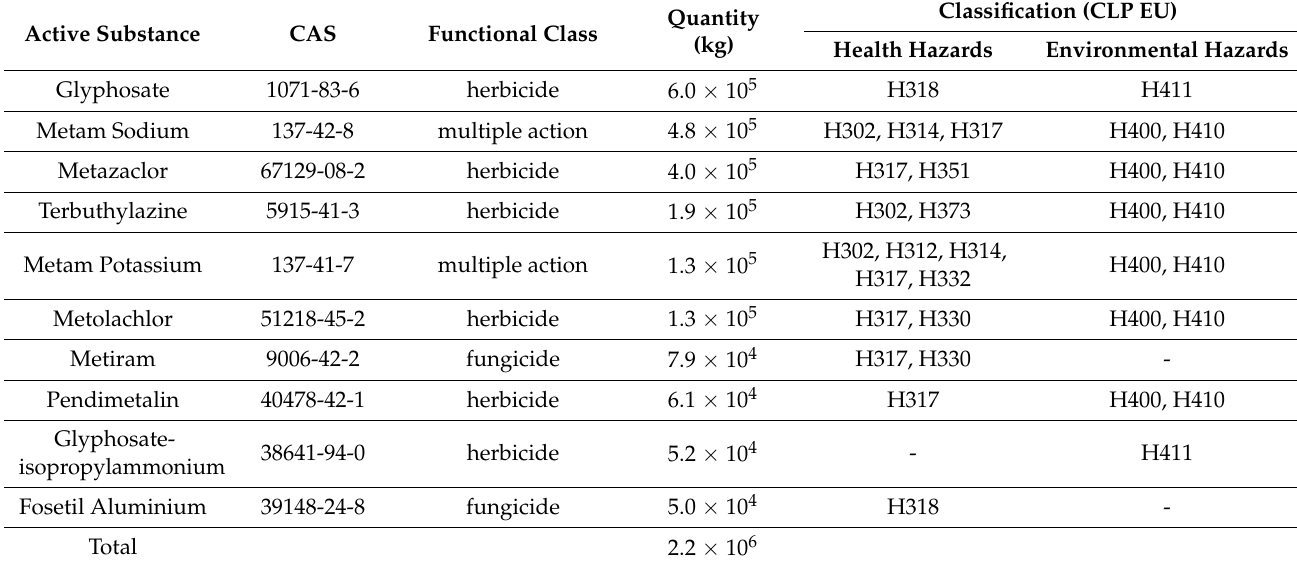
Table 3. Ten best-sold traditional farming active substances in Lombardy in 2016, their functional class, the sold quantity, and their hazard classification according to CLP EU